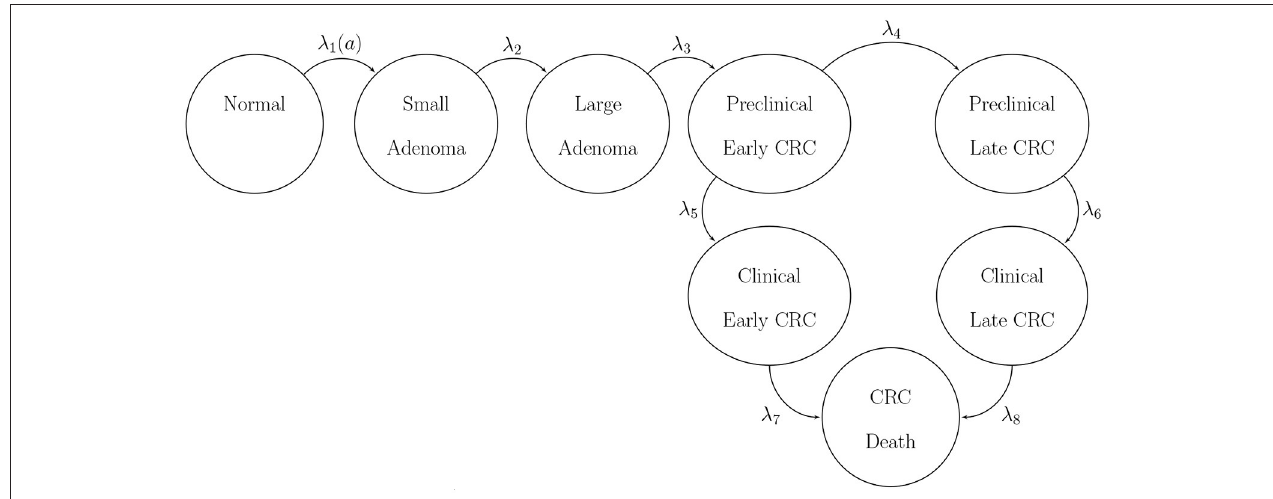
FIGURE 2 | State-transition diagram of the natural history model of colorectal cancer. Ovals represent health states and arrows represent transitions. All states can transition to death from causes other than CRC with rate µ ( a ). CRC, colorectal cancer.